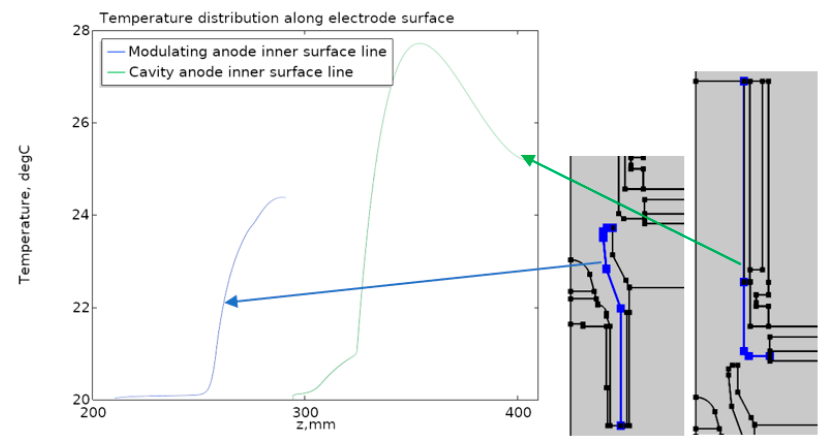
Figure 3. Temperature profile on the inner surface of the hottest elements.